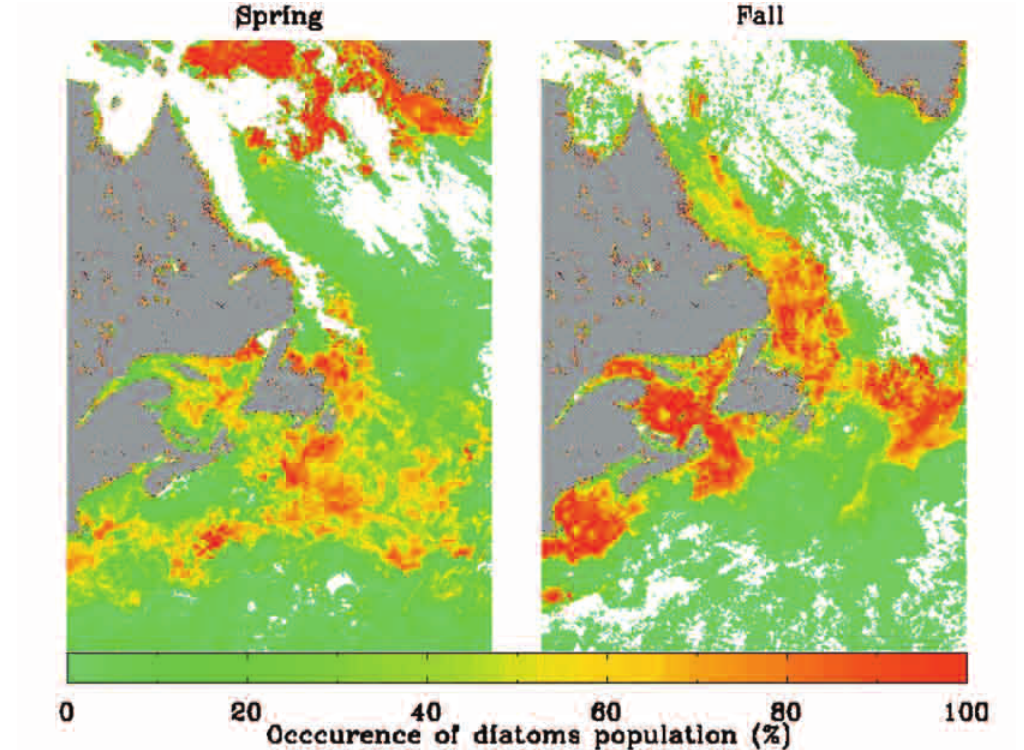
Fig. 6. – Composite images of diatoms population identification for the Spring and Fall 2003 in the North-West